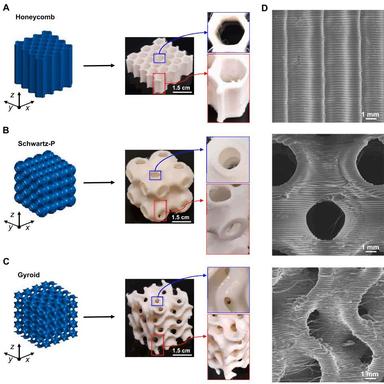
FLatt Pack design matrix lattices and corresponding 3D-printed (A) honeycomb, (B) schwartz-P, and (C) gyroid matrix soft scaffolds built with the TPU filament. The magnification of the upper surface (in blue) and sidewalls (in red) shows the printing quality of all soft lattices without any visible voids, imperfections, or irregularities after the manufacturing process. (D) SEM images of the TPU-based lattice structures. No visible defects, sagging, and improper layer adhesion are observed in all honeycomb